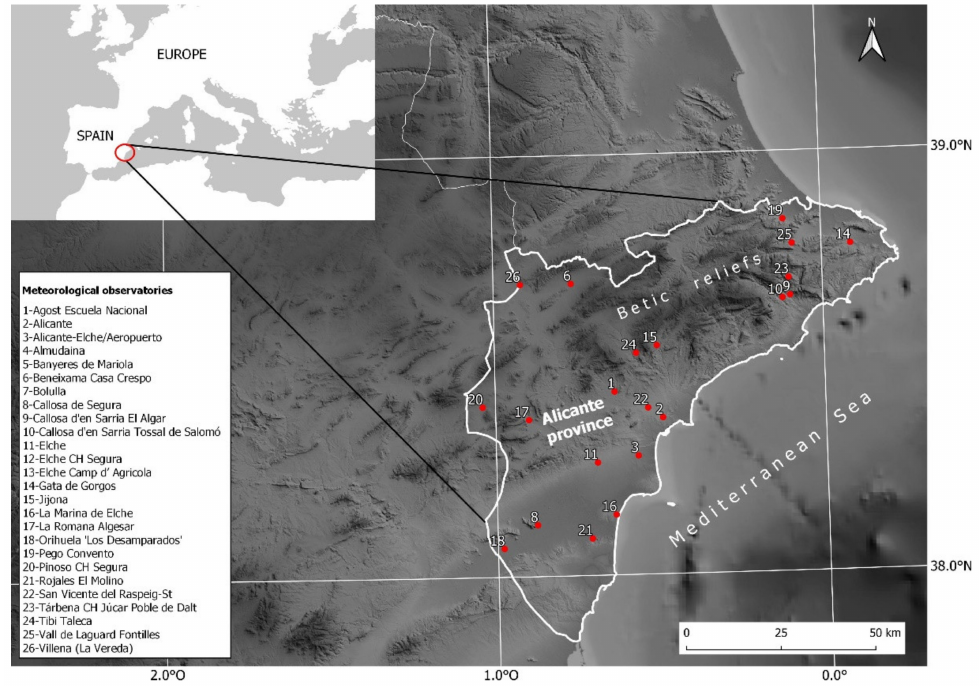
Figure 1. Geographic location of meteorological observatories that have recorded rainfall equal to, or greater than, 100 mm/day in the province of